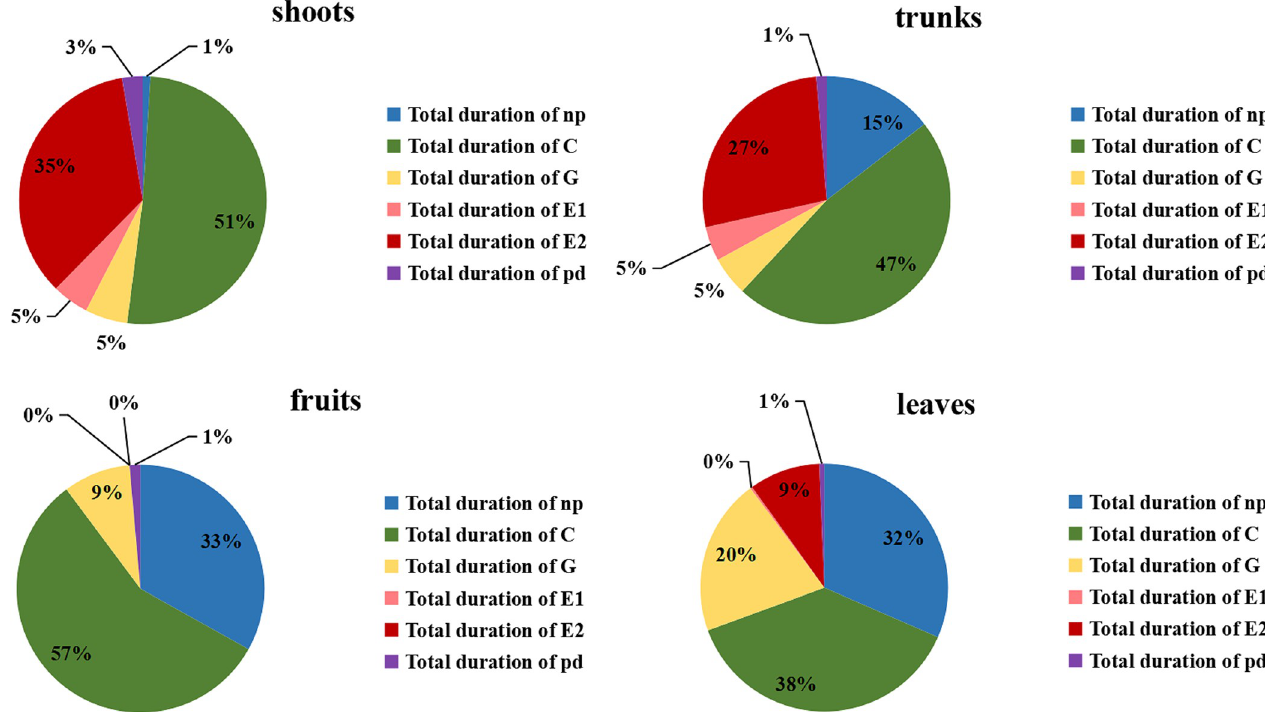
Fig 3. The percentage of various waveforms’ (average duration) of per aphid ( Eriosoma lanigerum ) feeding on different parts of apple tree for eight hours.